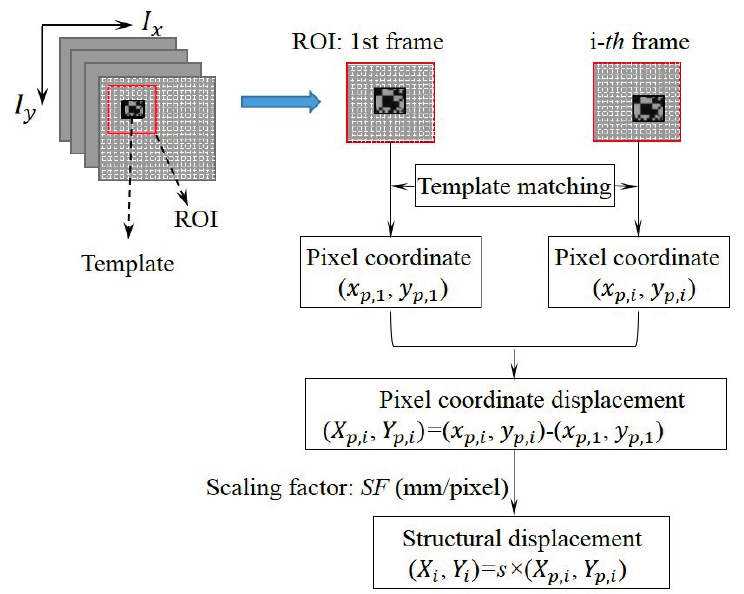
Figure 1. Procedure of vision sensor